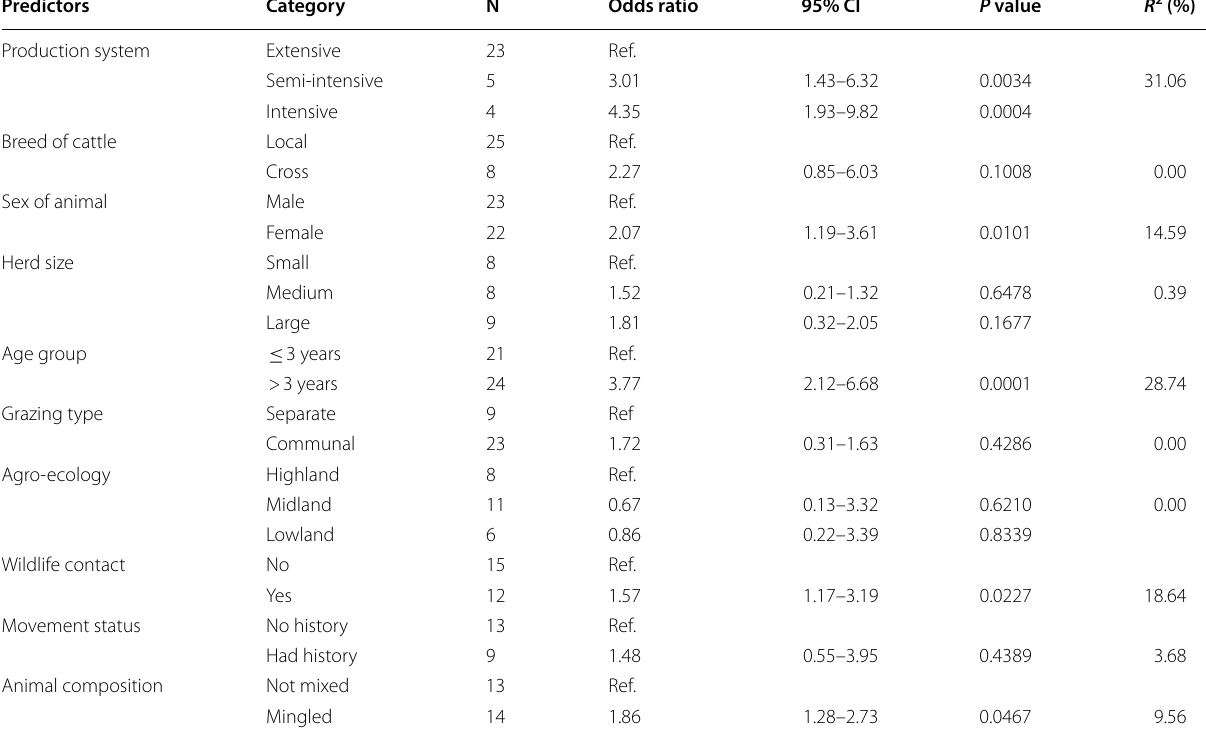
R 2 : Amount of heterogeneity accounted for the observed variation